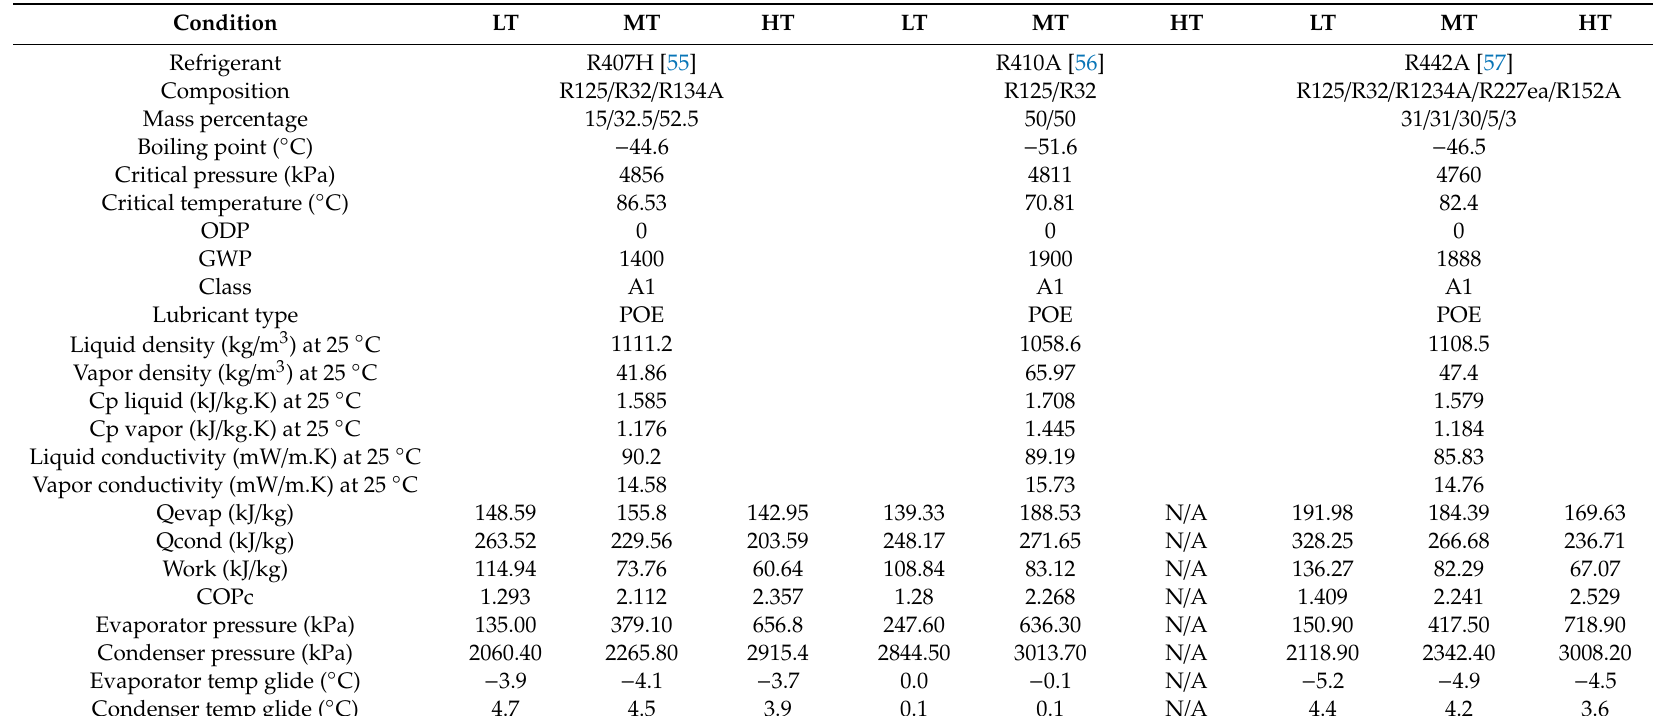
Table 6. Properties of R407H, R410A, and